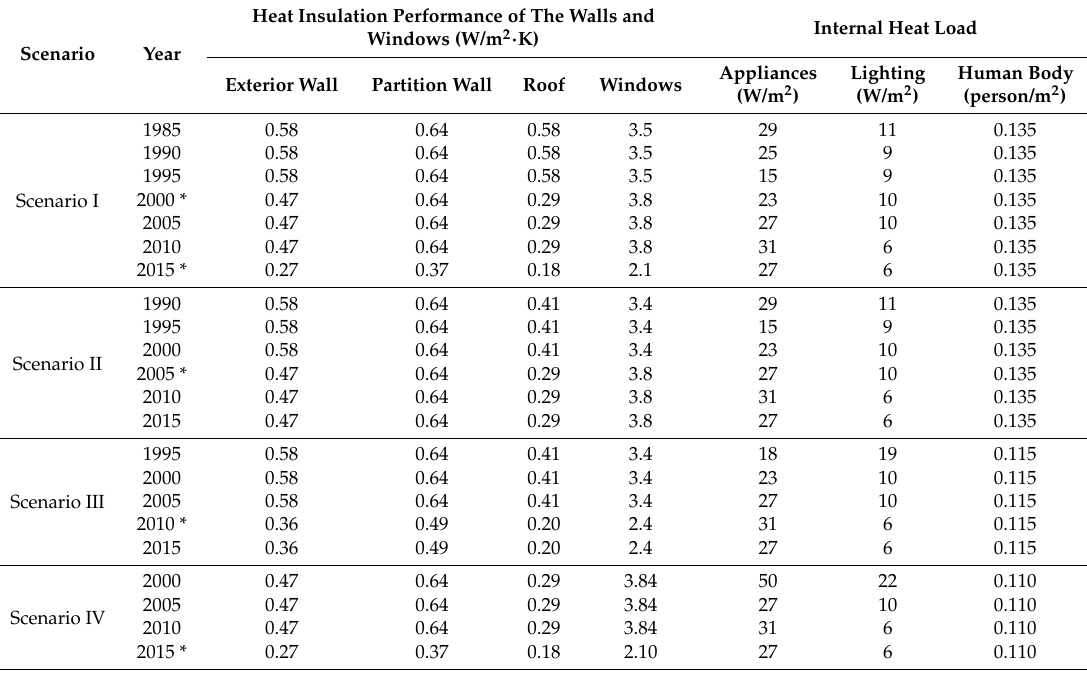
Table 11. The results of calculation of the skin loads and internal loads for each scenario.